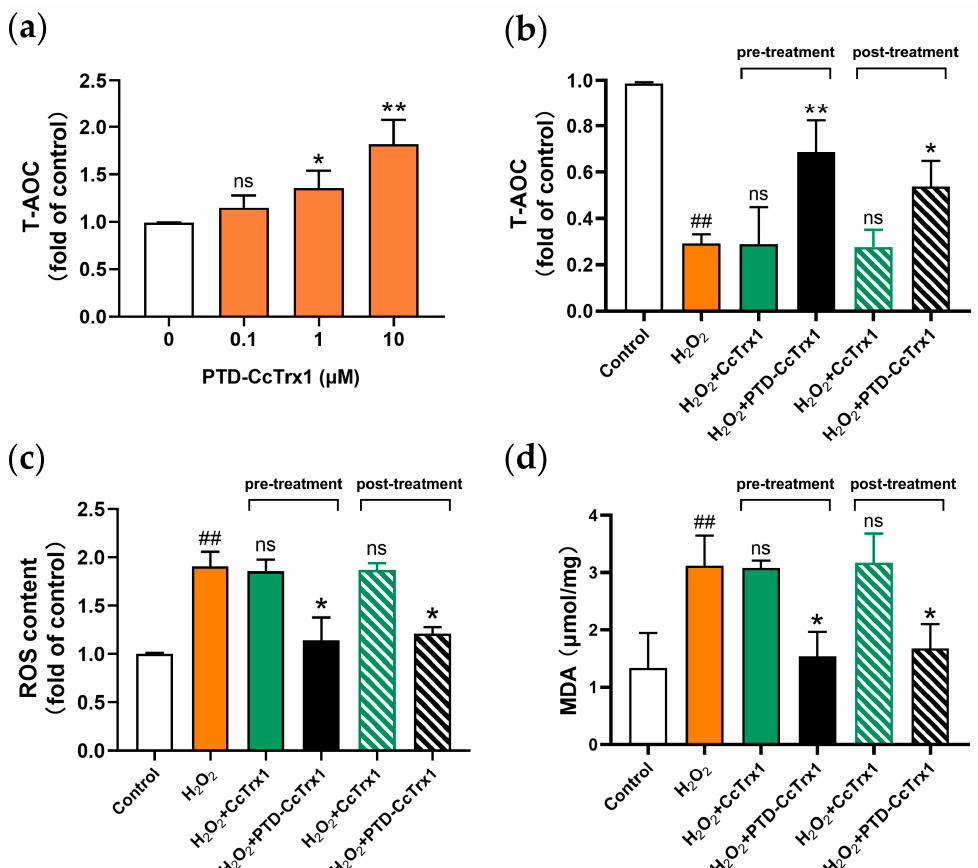
Figure 6. Attenuation of H 2 O 2 -mediated oxidative stress in HaCaT cells by PTD-CcTrx1. ( a ) The total antioxidant capacity (T-AOC) in HaCaT cells after treatment with different concentrations of PTD-CcTrx1 for 2 h (ns, no significance, * p < 0.05, ** p < 0.01 vs. control group). ( b ) PTD-CcTrx1 attenuated the decrease of T-AOC induced by H 2 O 2 . HaCaT cells were treated with 10 μ M CcTrx1 and 10 μ M PTD-CcTrx1 before or after the exposure to 400 μ M H 2 O 2 . Afterward, the cells were rinsed with ice-cold PBS and treated with 80 μ L of cell lysis buffer. Then, cell lysates were scraped thoroughly for centrifugation, and the supernatants were collected to detect the T-AOC. ( c ) ROS increase induced by H 2 O 2 was attenuated by PTD-CcTrx1. After treatment, HaCaT cells were rinsed with PBS before undergoing DCFH-DA staining and then detected under a fluorescence microplate reader. ( d ) Analysis of MDA generation and lipid peroxidation. After treatment, cell lysates were scraped thoroughly and the supernatants were collected to quantify the MDA level. All treatments were performed in triplicate individually, with values expressed as mean ± SD (## p < 0.01 vs. control; ns, no significance, * p < 0.05, ** p < 0.01 vs. H 2 O 2 alone group).